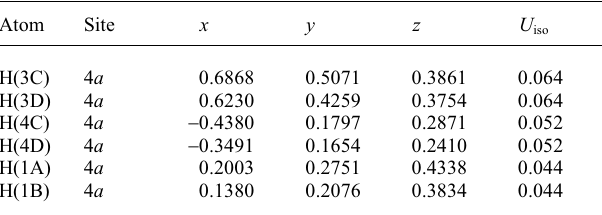
Table 2. Atomic coordinates and displacement parameters (in Å 2 )